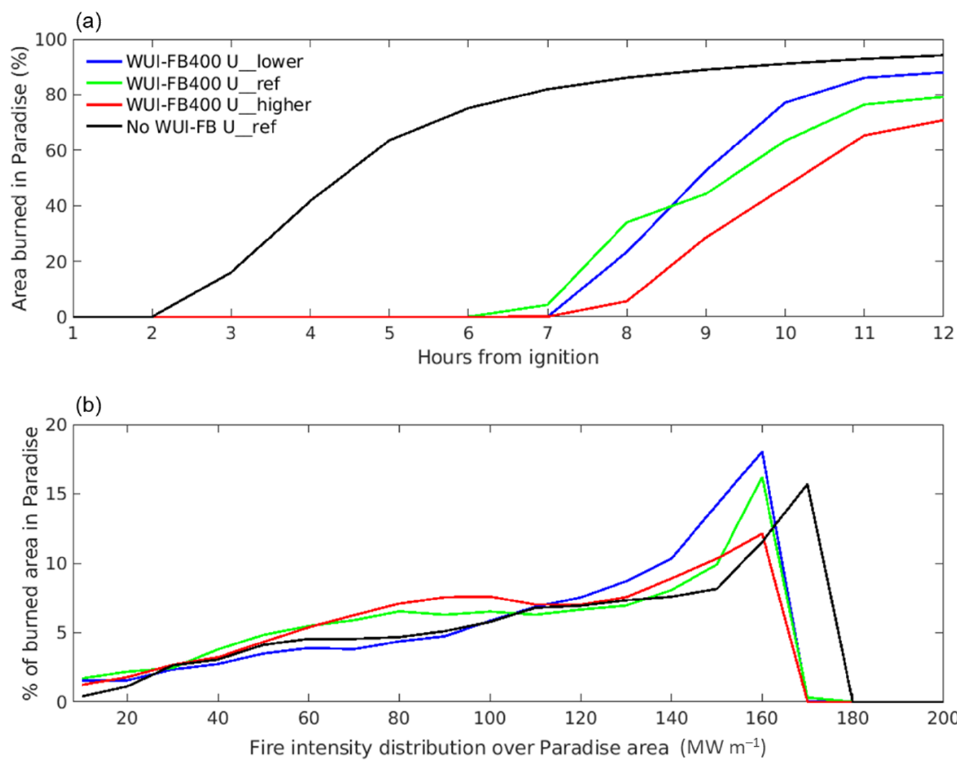
Figure 9. ( a ) Time vs. area burned in Paradise and ( b ) fire intensity distribution vs. percent of the total area burned in Paradise at the end of the simulations with three different constant wind speed inputs. See Tables 2 and 3 for the experimental settings of each simulation name.